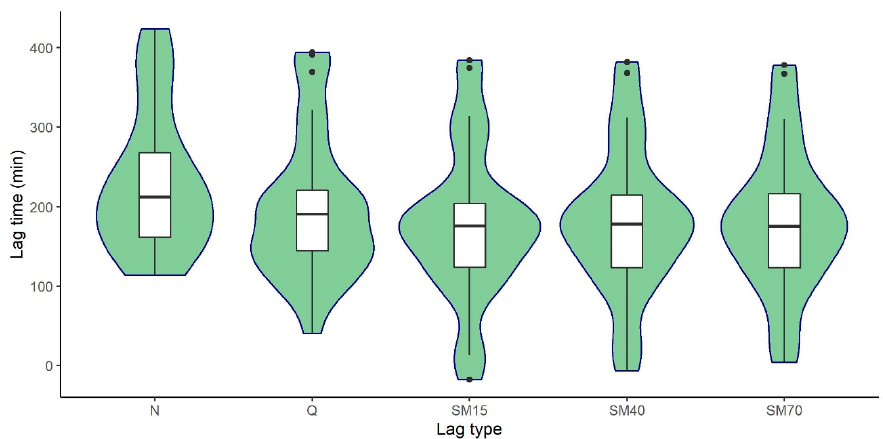
Figure 5. Violin boxplot of calculated time lags between centroids of precipitation hyetograph and: hydrograph (Q), NO 3 -N flux (N), soil moisture at 15, 40, and 70 cm depth (SM15, SM40, SM70).